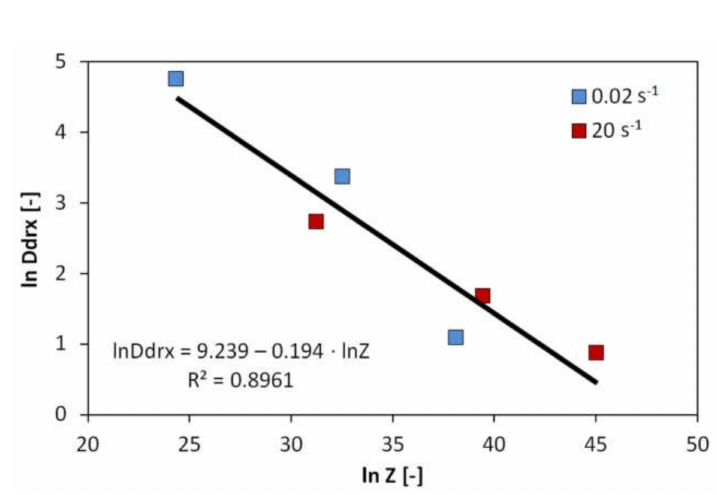
Figure 25. Graphical representation of the influence of deformation conditions on the size of dynamically recrystallized grain (strain e =